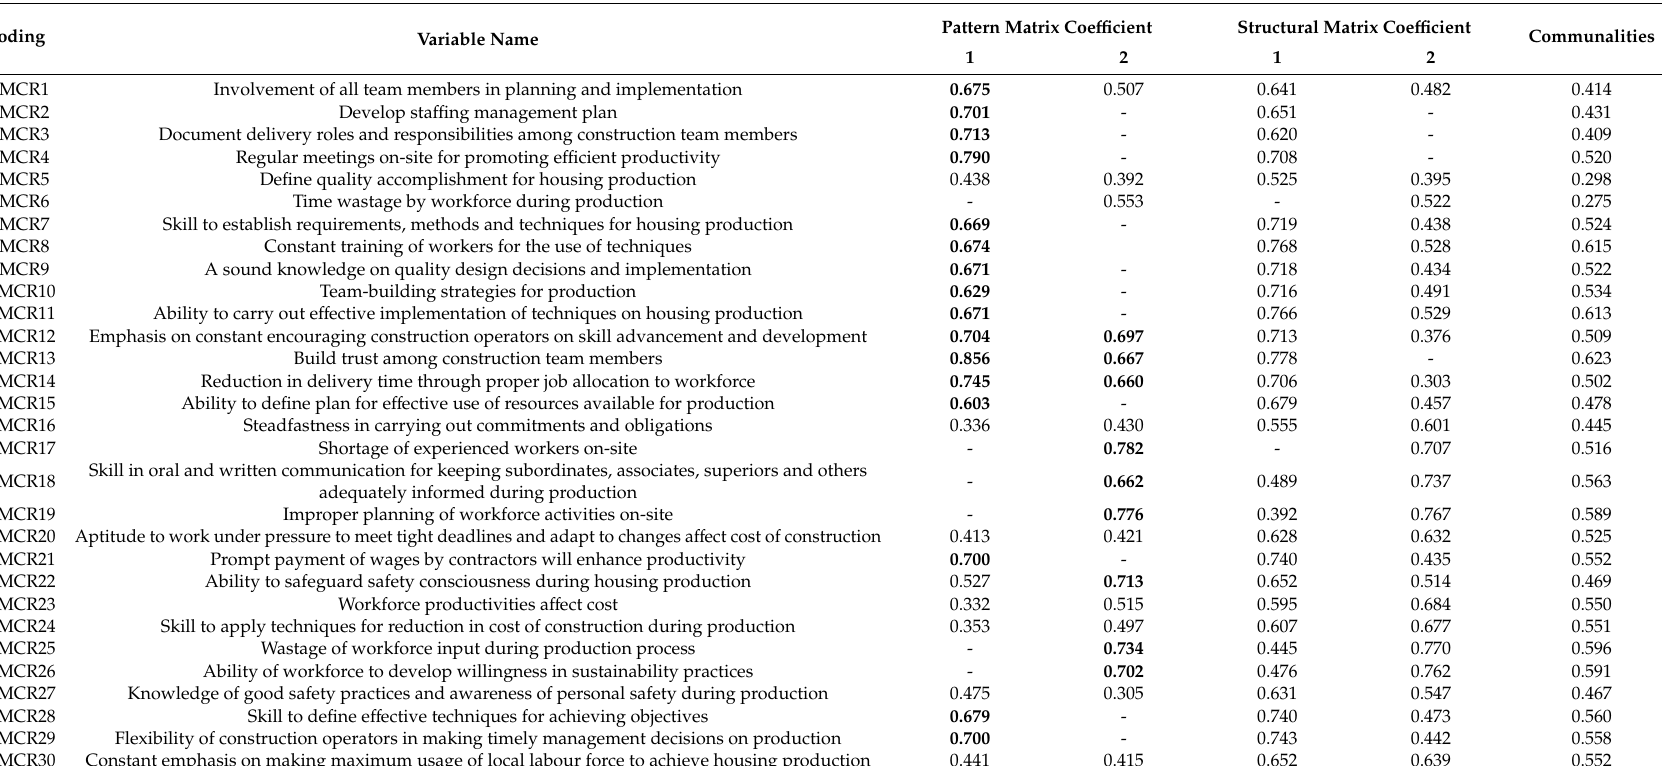
Table 4. Pattern matrix and structural matrix for principal component analysis (PCA) with Oblimin Rotation of ICMCR (human resources) variables.